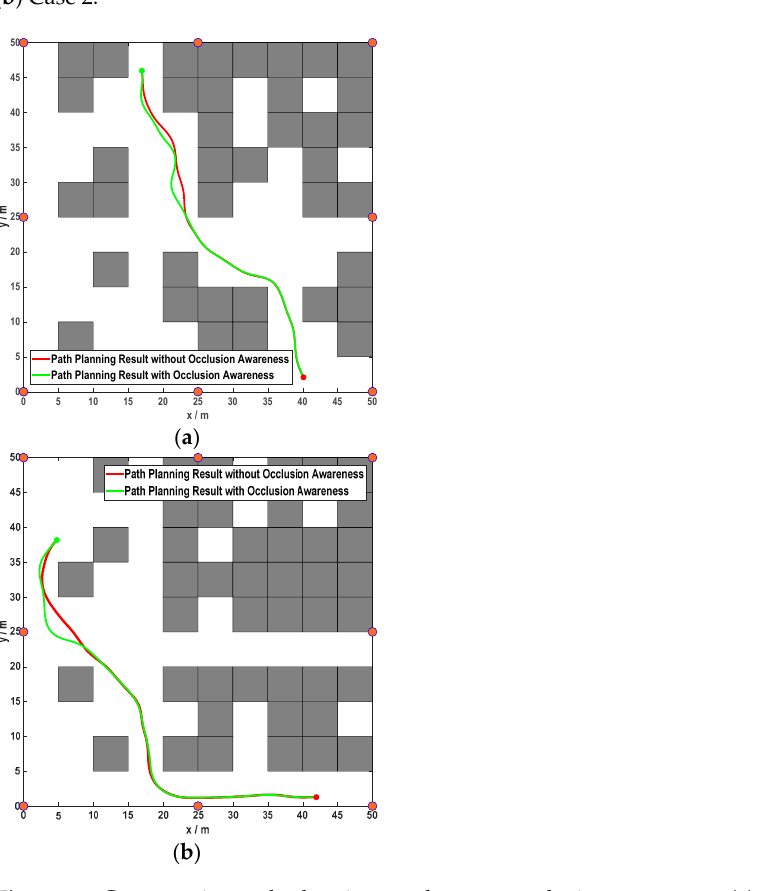
Figure 9. Path planning performance, w.r.t. collision avoidance, and kinematic feasibility: ( a ) Case 1; ( b ) Case 2.